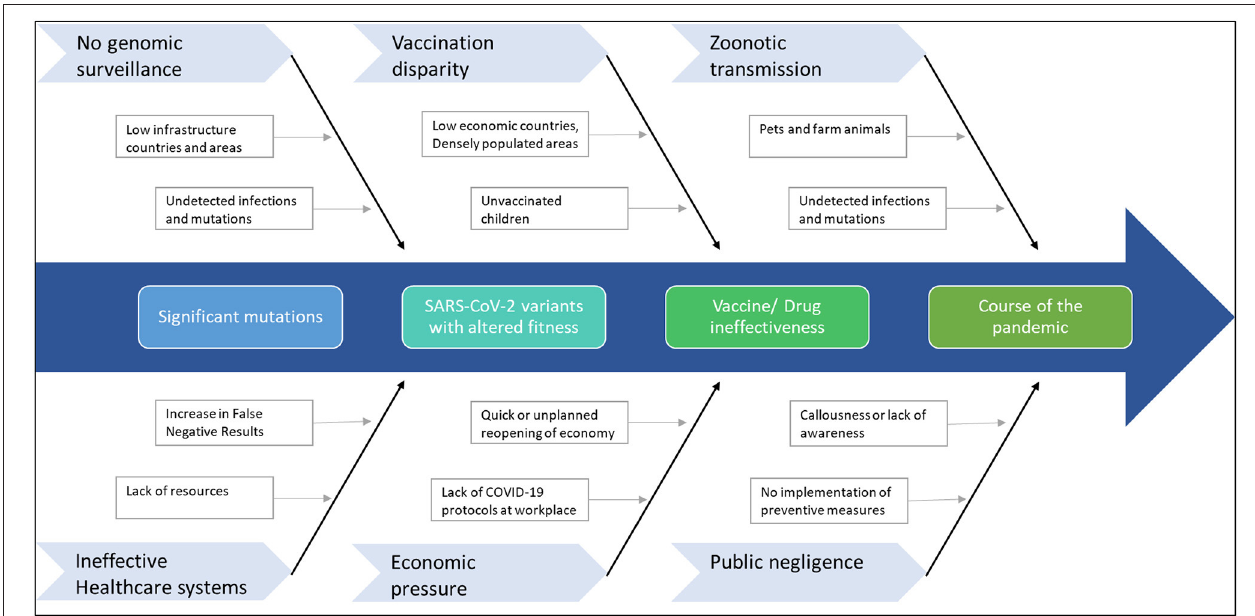
FIGURE 3 | Factors that can contribute to further mutations in SARS-CoV-2. The emergence of any immune-escape variants can change the course of the pandemic.